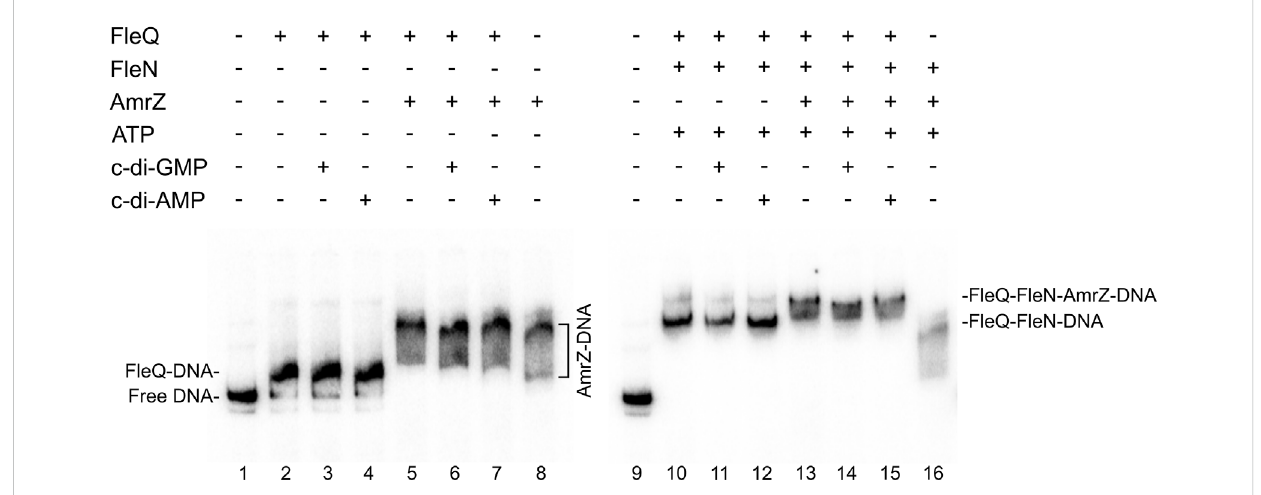
FIGURE 5 In vitro binding ofthe FleQ-FleN complex to the wss promoter region inthe presence of AmrZ.Binding reactions were carried out inthe absence (-) and in the presence (+) of FleQ, FleN, AmrZ and ATP, GTP, c-di-GMP or c-di-AMP. Putative shifted protein-DNA complexes are